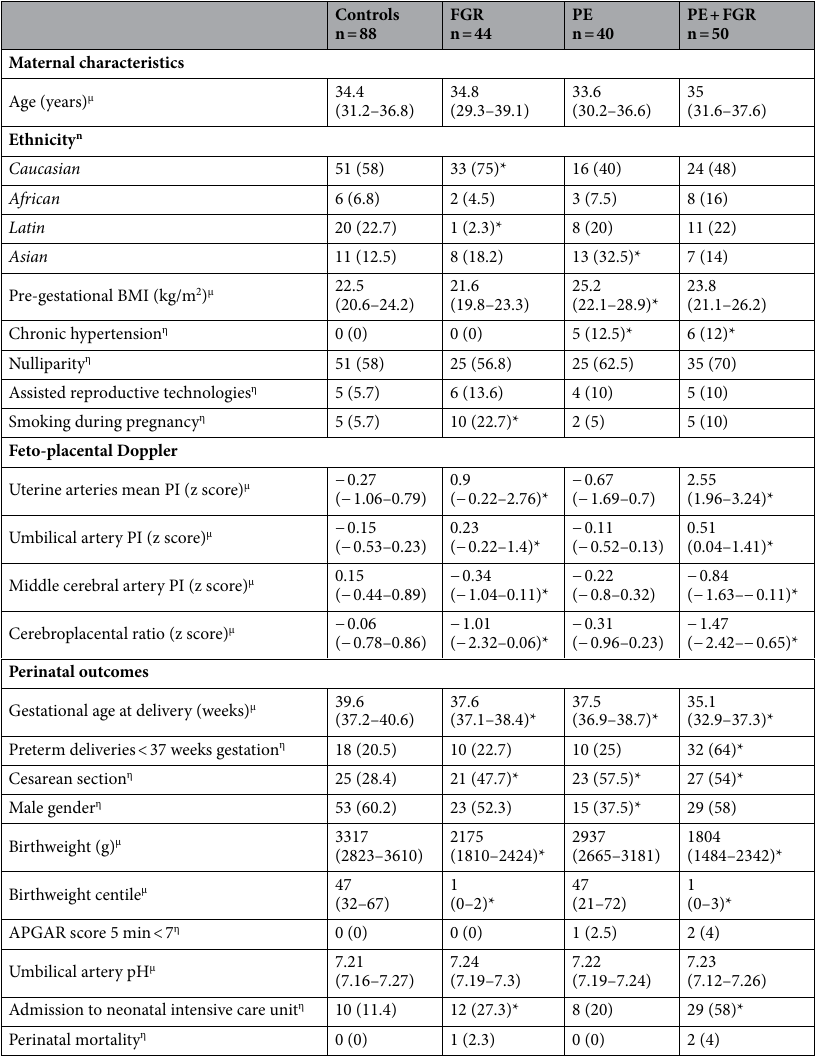
Table 1. Maternal and perinatal characteristics of the study population. Controls are normotensive pregnancies with appropriate growth for gestational age fetuses. Perinatal mortality was defined as stillbirth or neonatal mortality within 28 days of delivery. BMI, body mass index; PI, pulsatility index. μ Data are median (interquartile range). η Data are n (%). *p < 0.05 by Mann Whitney U test, Pearson χ 2 or Fisher exact tests as appropriate, compared to